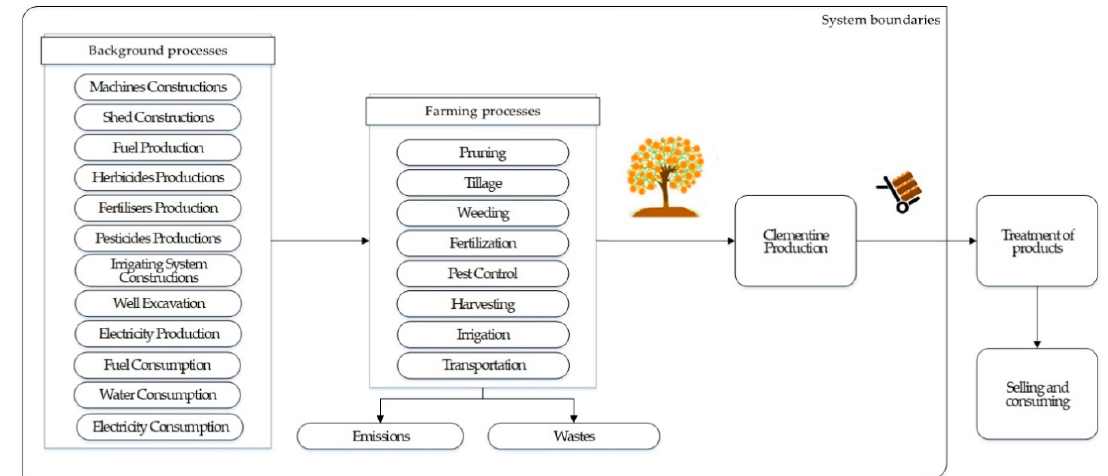
Figure 4. System boundaries flow chart.